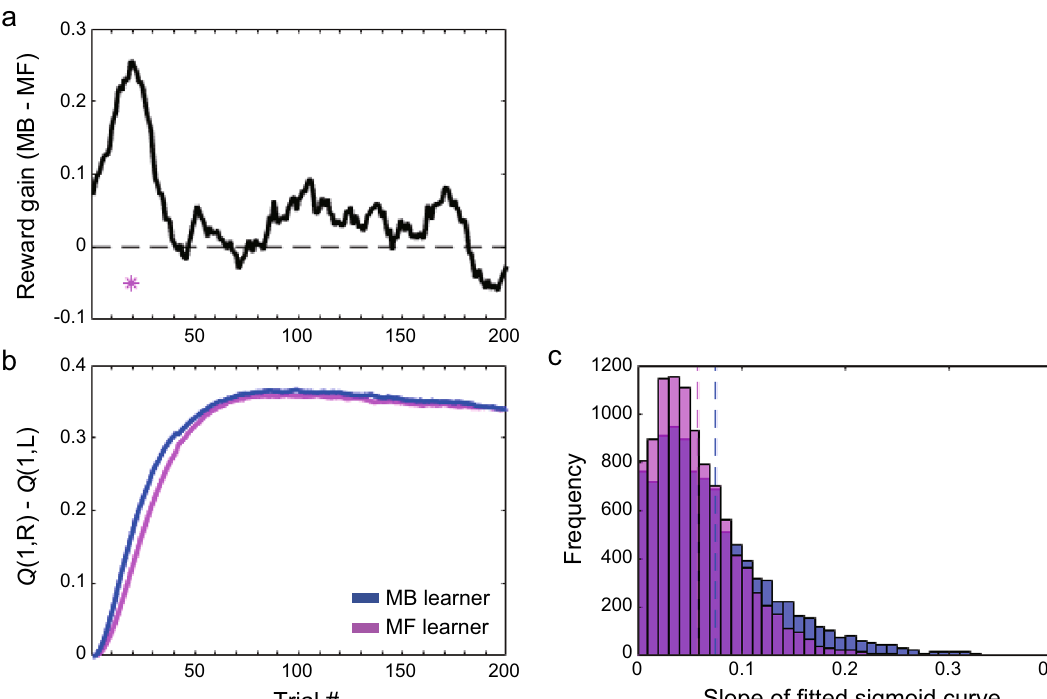
Figure 6. Simulating model-based and model-free behavior. ( a ) Difference between rewards earned by the model-based and model-free learners simulated with different weight parameters of the HYBRID model. * indicates p < 0.001. ( b ) State-action values at the first choice ( Q [1,R] for the right choice, Q [1,L] for the left choice) estimated from simulations of model-free (magenta) and model-based (blue) learners. ( c ) The histogram of the slope of the sigmoid function fitted to the difference of state action values in ( b ). The dotted lines represent the